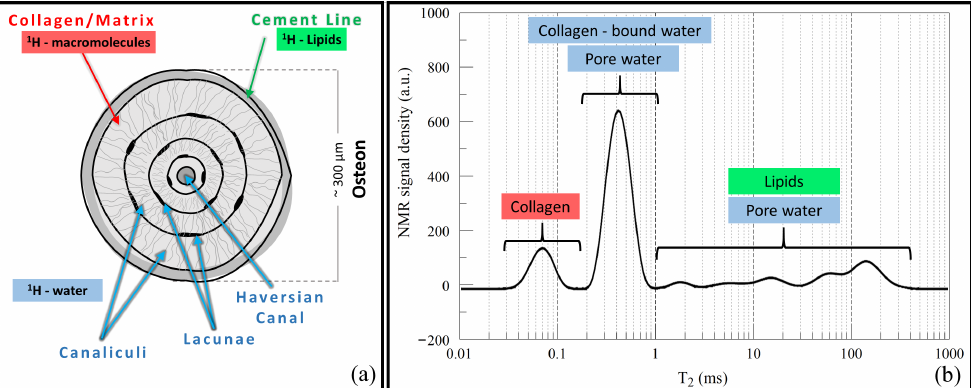
Figure 1. ( a ) Schematic representation of cortical bone indicating its constituents and compounds from which the 1 H NMR signal arises; ( b ) T 2 distribution of human cortical bone (plot from data presented in reference